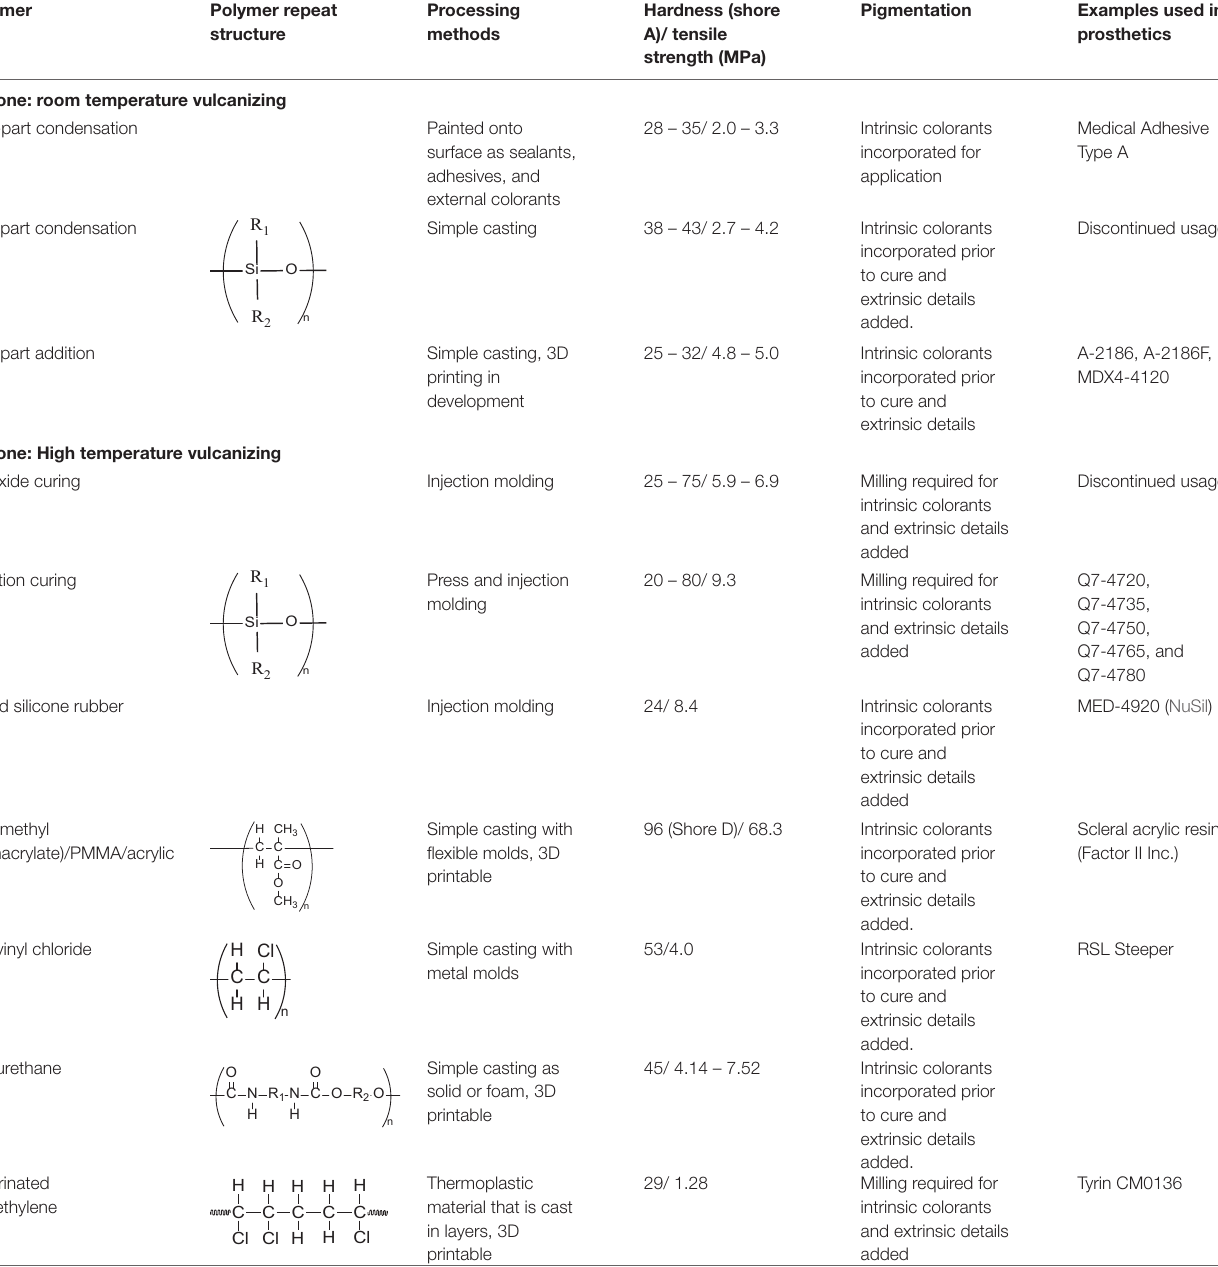
TABLE 1 | Properties of polymers historically used in soft tissue